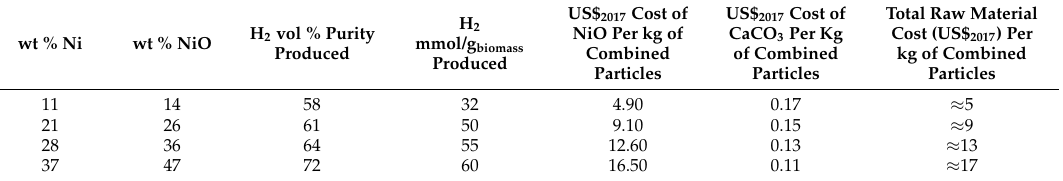
Table 6. Raw material costs for combined particles. Yields of H 2 per gram of biomass was estimated based on an average between the largest and smallest particle sizes due to the larger uncertainty of the data. Costs estimated from Alibaba.com, ~35 US$ 2017 per kg NiO (assuming NiO as the Ni source), ~0.2 US$ 2017 per kg CaCO 3